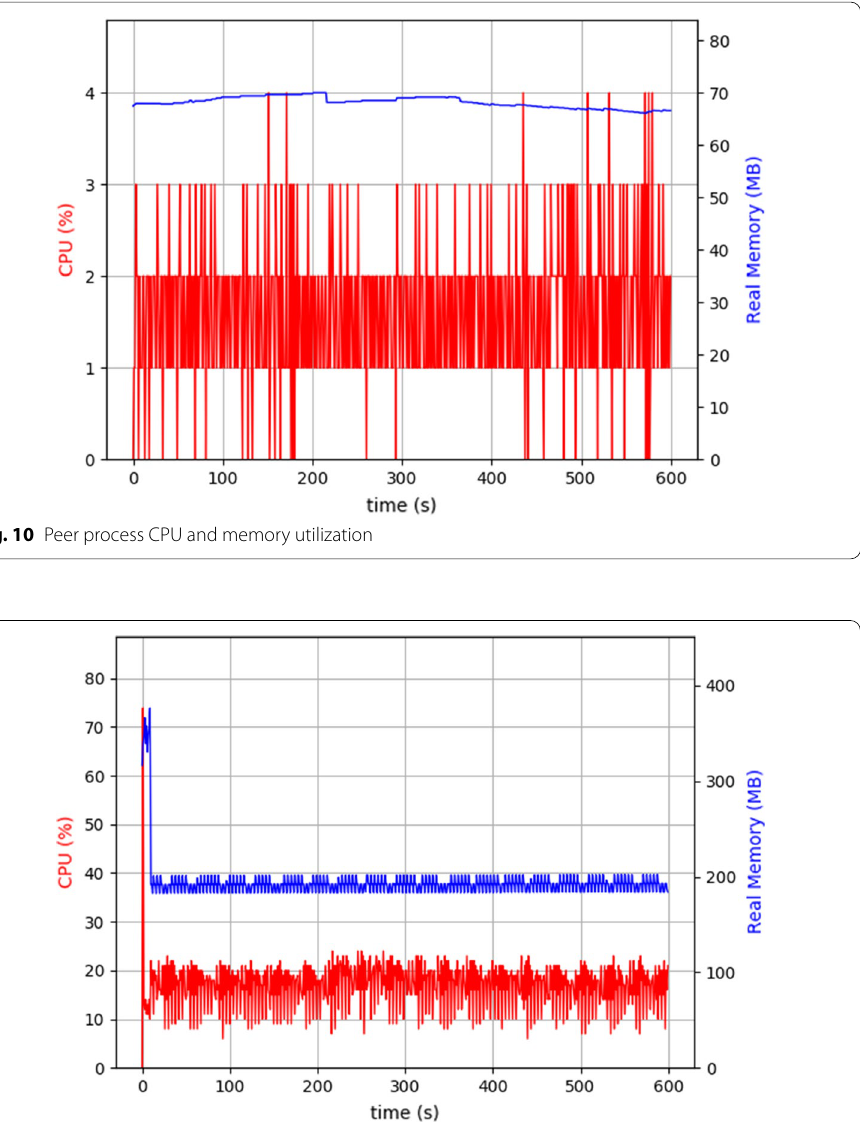
Fig. 11 Client application CPU and memory